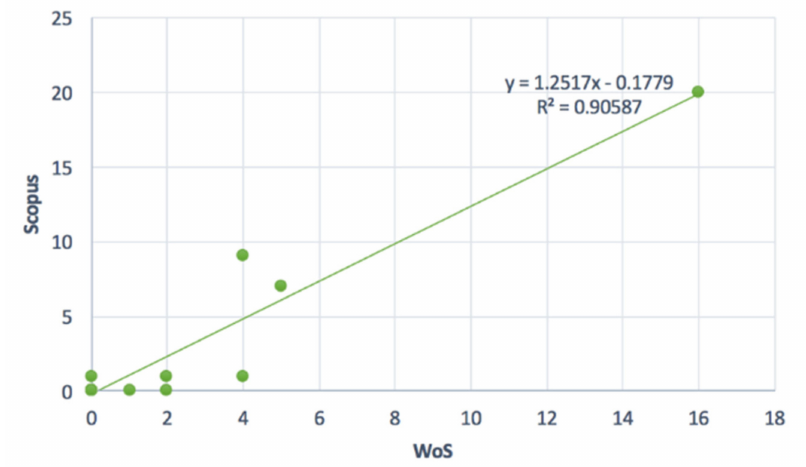
Figure 7. Correlation between the number of citations by article published per year in WoS and Scopus. Source: Own elaboration.